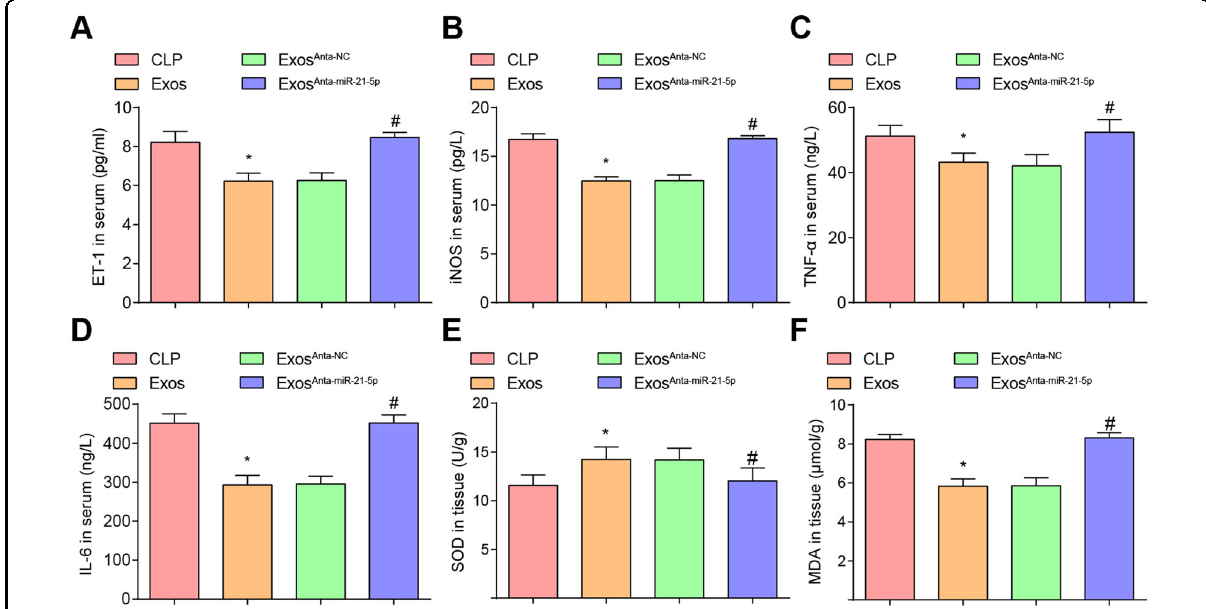
Fig. 7 EPCs-Exos diminish the in fl ammatory and oxidative stress responses in CLP rats. A Comparison of serum ET-1 levels in CLP rats. B Comparison of serum iNOS levels in CLP rats. C Comparison of serum TNF- α levels in CLP rats. D Comparison of serum IL-6 levels in CLP rats. E Comparison of tissue SOD activity in CLP rats. F Comparison of tissue MDA levels in CLP rats. n = 10. * P < 0.05 vs. the CLP group. # P < 0.05 vs. the Exos Anta-NC group. Measurement data were depicted as mean ± standard